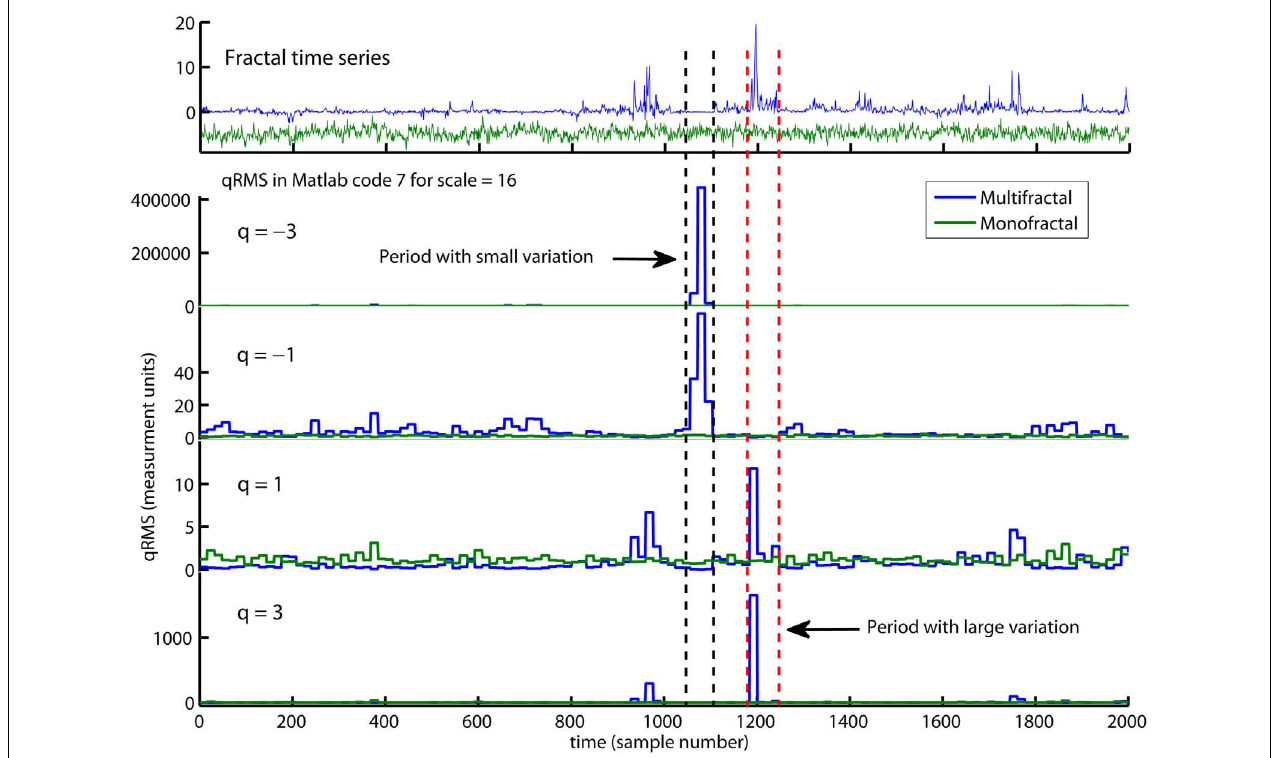
the segments with extreme large RMS{1} . Notice that q =− 3 and q = 3 amplify the small and large variation, respectively, more than q =− 1 and q = 1. Notice also that the monofractal time series has no segments with extreme large or small fluctuations and, thus, no peaks in qRMS{1} . The overall q -order RMS is able to distinguish between the structure of small and large fluctuations and, consequently, between the monofractal and multifractal time